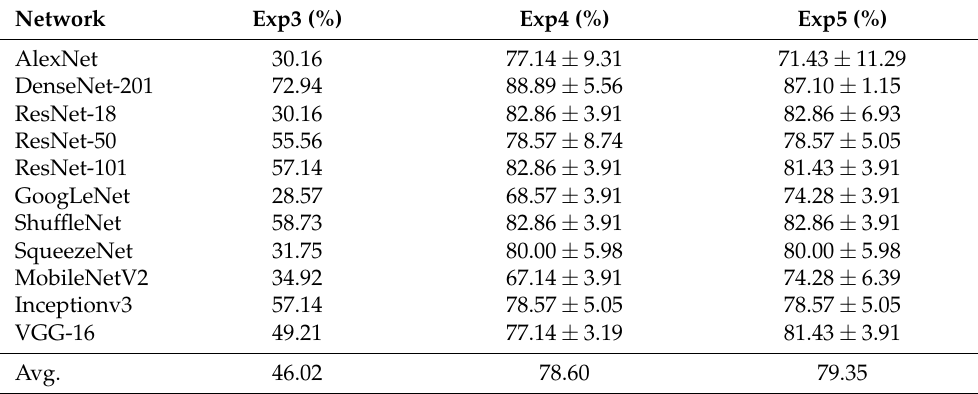
Table 5. Cross-dataset experiments for multiclass classification on